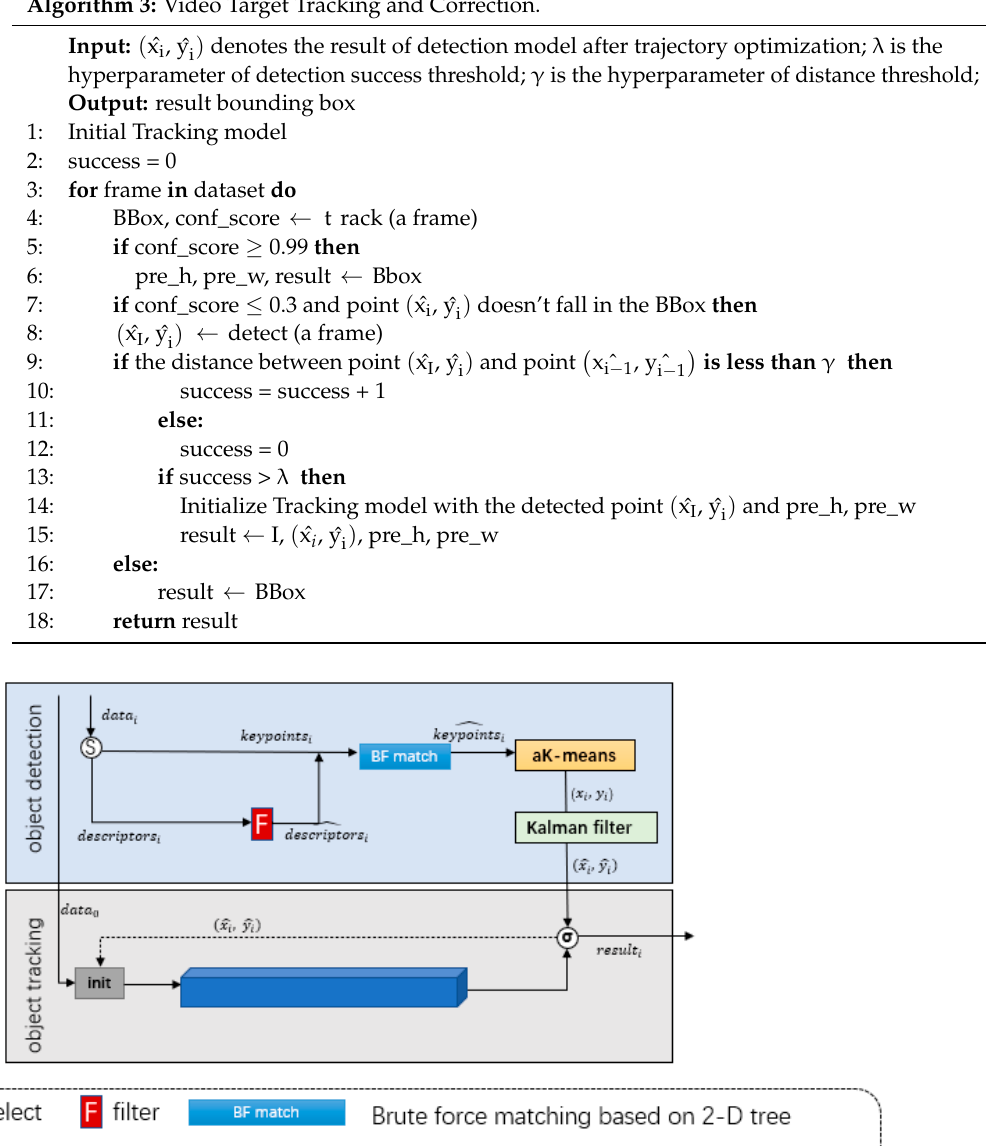
Algorithm 3: Video Target Tracking and Correction.